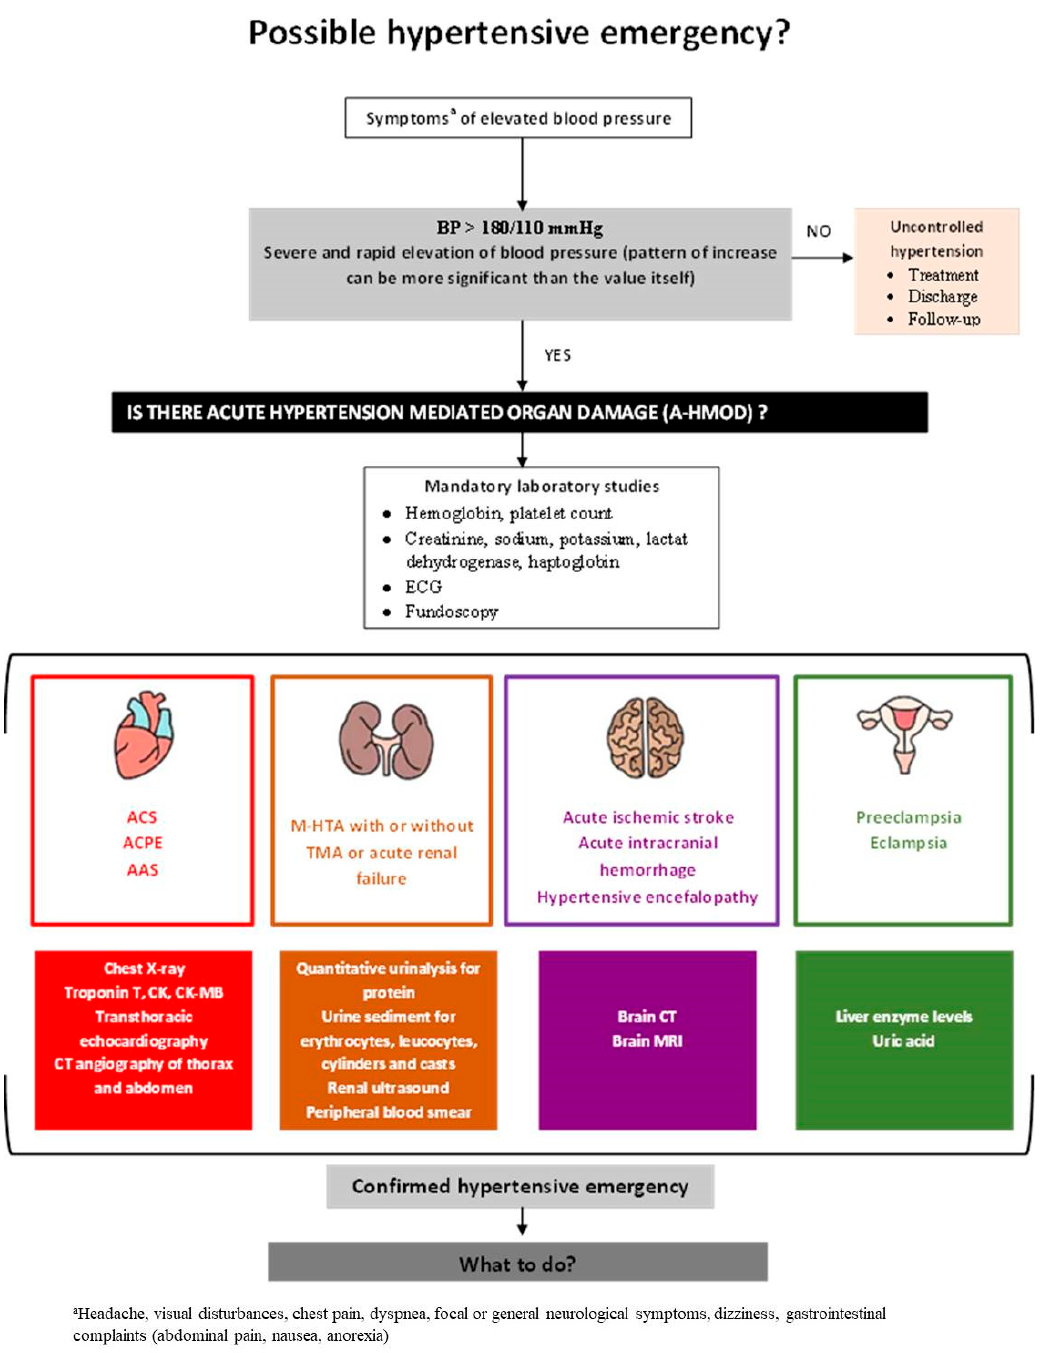
Figure 1. Diagnostic algorithm of possible hypertensive emergencies . BP—blood pressure; ECG—electrocardiography; ACS—Acute coronary syndrome; ACPE—Acute cardiogenic pulmonary oedema; AAS—Acute aortic syndrome; M-HTA—Malignant hypertension; CK—Creatine kinase; CK-MB—Creatine kinase-MB; CT—Computer tomography; MRI—Magnetic resonance imaging. According to Table 1 and Figure 2.